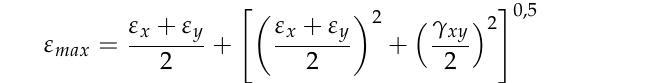
where ε x , ε y are the strains measured in the x and y directions and γ xy is the shear strain. As in the precedent case (Figure 5), an increase could be observed in the strain with each step of temperature increase. Increasing the temperature to 85 ◦ C induced a maximum principal strain above 900 microstrains, which was higher than the allowable value of 700 microstrains